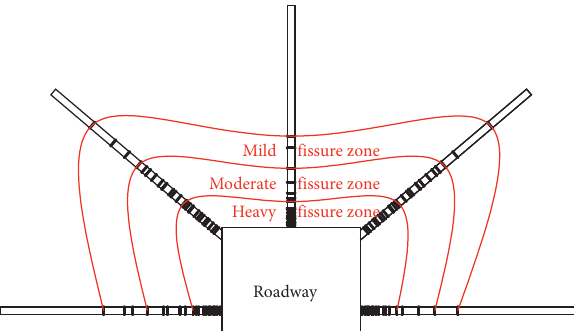
Figure 20: The observation result of surrounding rock deformation